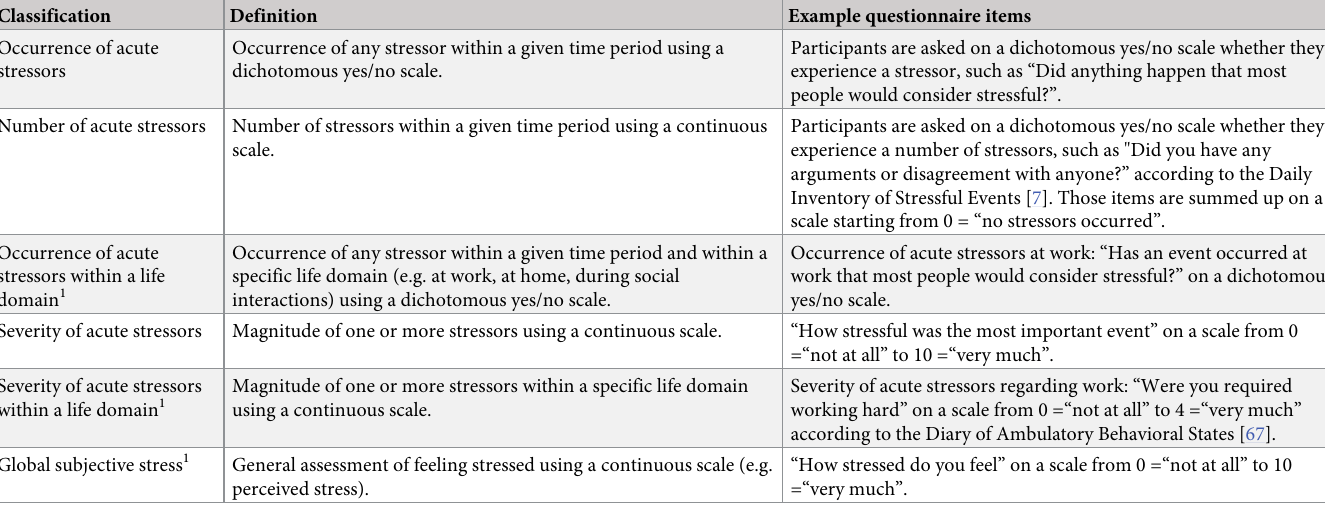
Table 2. Classification scheme of acute stressors and acute subjective stress as independent